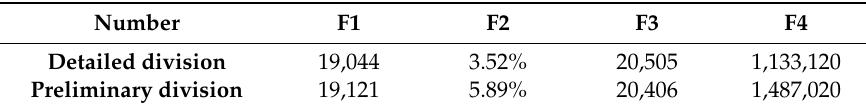
Table 6. Comparison of objective function